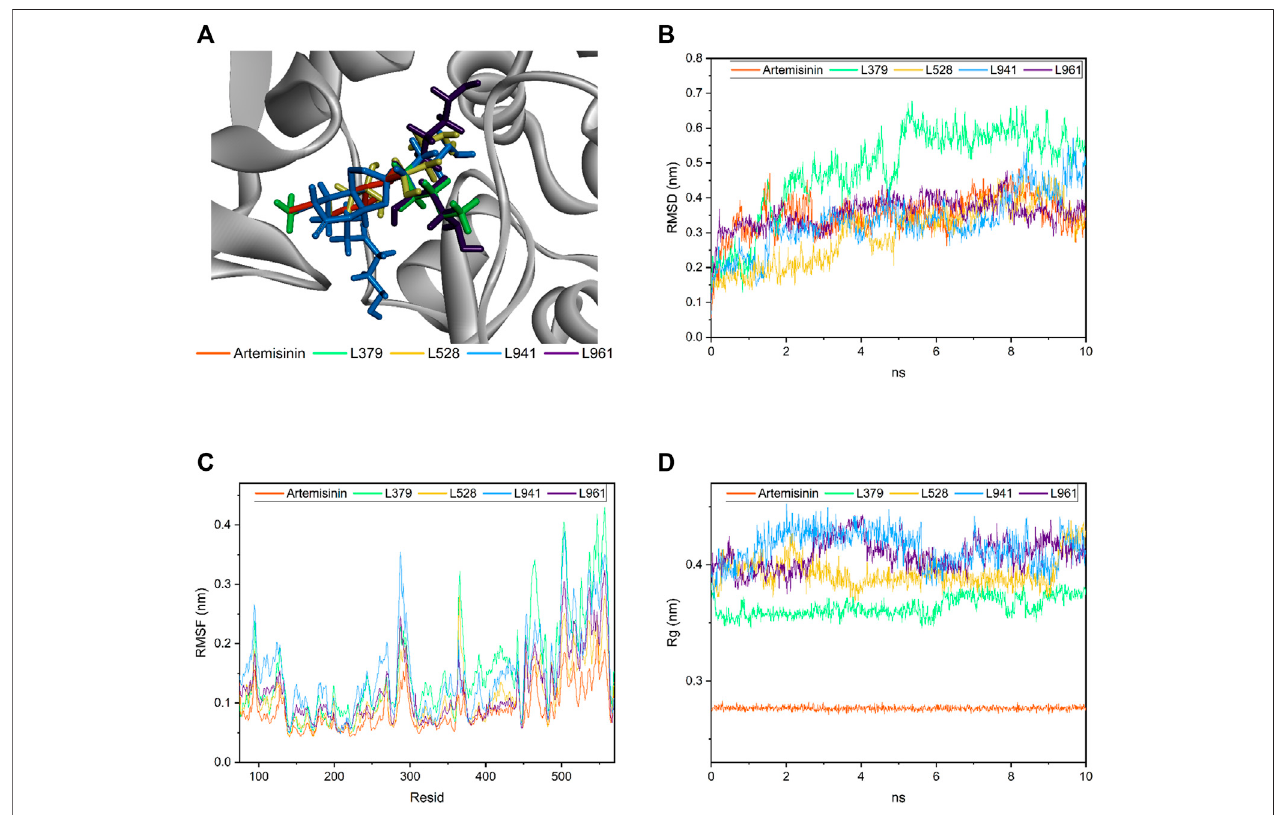
FIGURE 6 | Molecular dynamics of candidate compounds. (A) Binding orientation and location of all four candidate compounds and artemisinin in the docking study. (B) Therootmeansquaredeviation(RMSD)offourcandidatecompoundsandartemisinin. (C) Therootmeansquare fl uctuation(RMSF)valueofresidues. (D) The radius of gyration value in four candidate compounds and